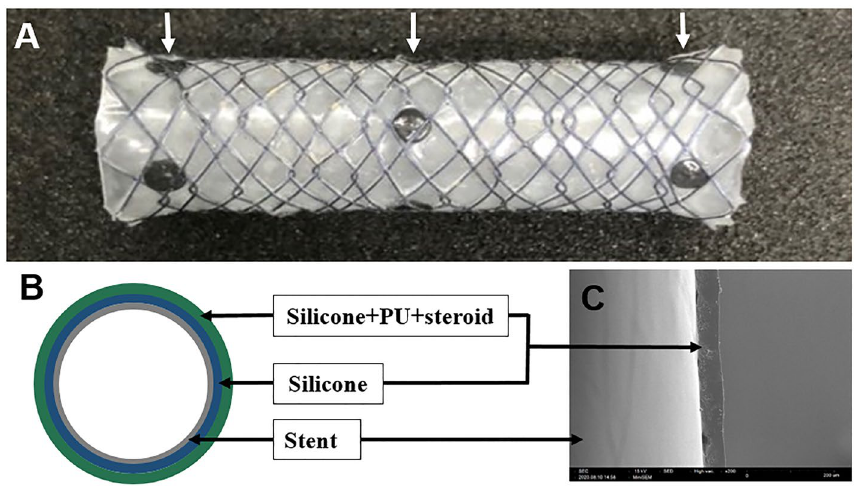
Figure 5. Fully covered self-expanding metal stent with a triamcinolone-incorporated membrane. ( A ) Photograph of the expanded stent with three radiopaque markers (in the middle and at both ends of the stent) used for proper positioning. ( B ) Schematic cross-section showing the silicone membrane forming the inner layer, and polyurethane membrane containing silicone and triamcinolone forming the outer layer. ( C ) Scanning electron micrograph of the stent membrane fabricated by the spray-coating technique, showing a uniform coating pattern. PU polyurethane. The thickness of the nitinol wire for the stent was 127 µm, and the hook and cross wire method was used for fabrication. Tantalum was used as the radiopaque marker material. Steroid refers to